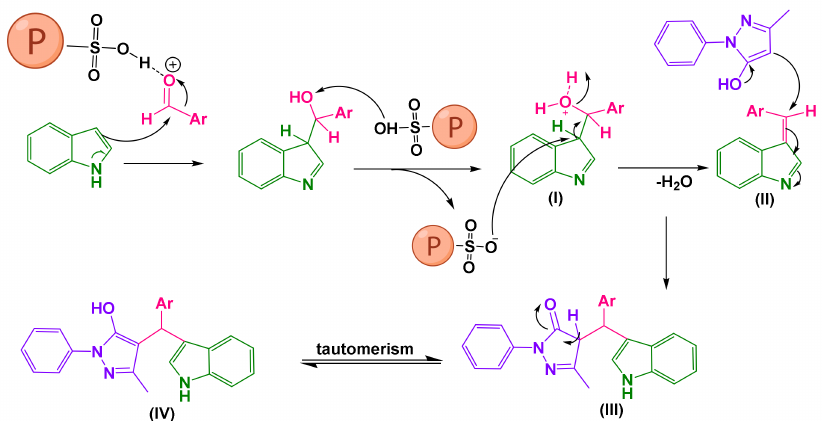
Figure 7. Suggested mechanism for the synthesis of 4-[(indol-3-yl)-arylmethyl]-1-phenyl-3-methyl-5- pyrazolones catalyzed by MSMF. ℗ represents polymer-based catalyst.